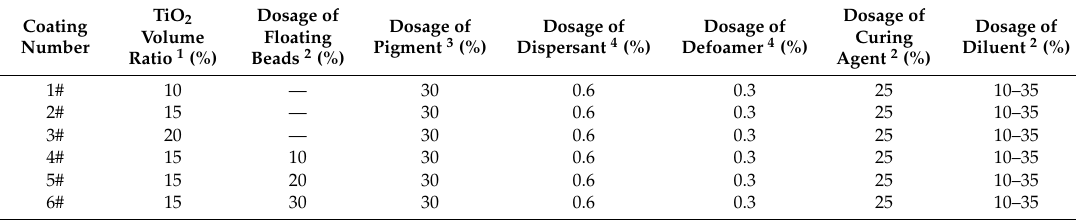
Table 1. Coating ratio design.